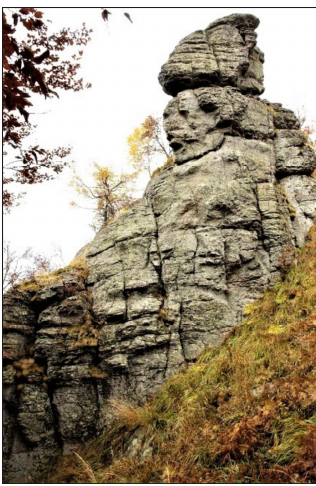
Figure 24. The “ Igniş Sphinx”, an amazing erosional volcanic landform of Igniş volcano (Photo Figure 24. The “Igni¸s Sphinx”, an amazing erosional volcanic landform of Igni¸s volcano (Photo credit: credit: Alec Portase). Alec